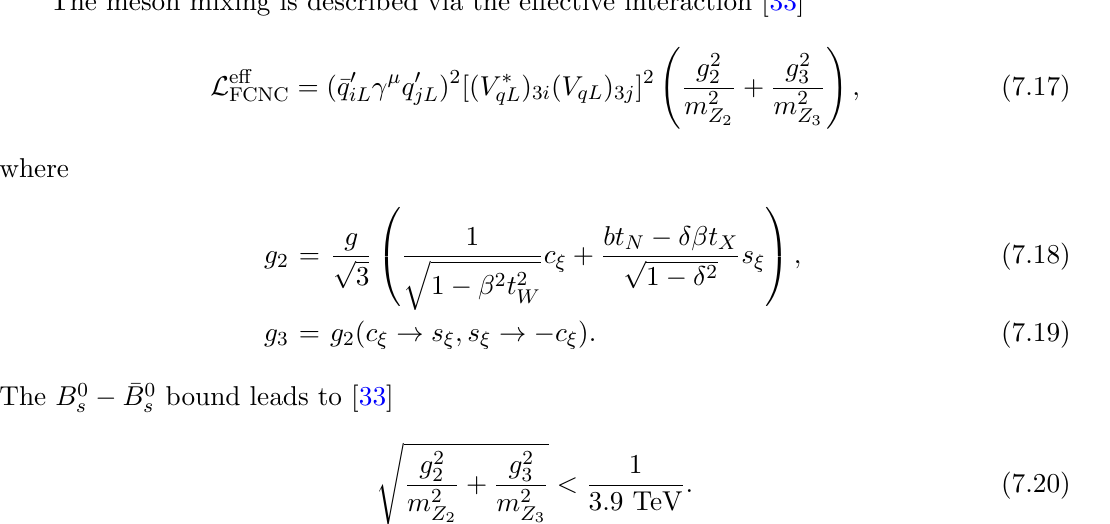
Figure 12 . The bounds on the new physics scales as functions of δ , contour by the three kinds of the models β = 1 / √ 3, β = 1 / √ 3, and β = −√ 3, respectively. − In figure 12, (cid:21) are contoured as the functions of ( w, δ ) for β = 1 , 2 β = −√ 3. It is clear that the new physics regime significantly changes when δ varies, in contradiction to